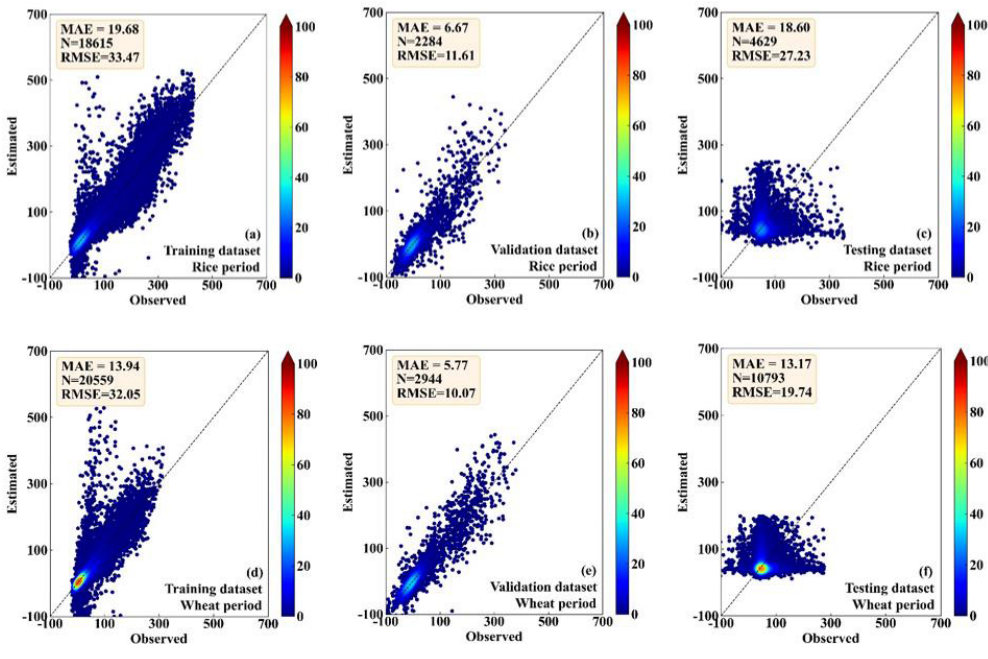
Figure 6. Same as Fig. 5 but for LE. Table 1. The MAEs and RMSEs of the RF-estimated heat fluxes for the four-variable input combinations, and the corresponding changes from the five-variable input